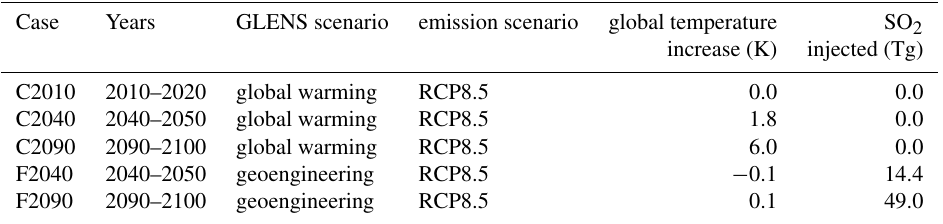
Table 1. Overview of the cases analysed in this study. In addition to the years considered, the underlying emission scenario in the GLENS simulation, the global temperature increase (referred to 2010–2020) and the SO 2 amount injected by that time period are given for each